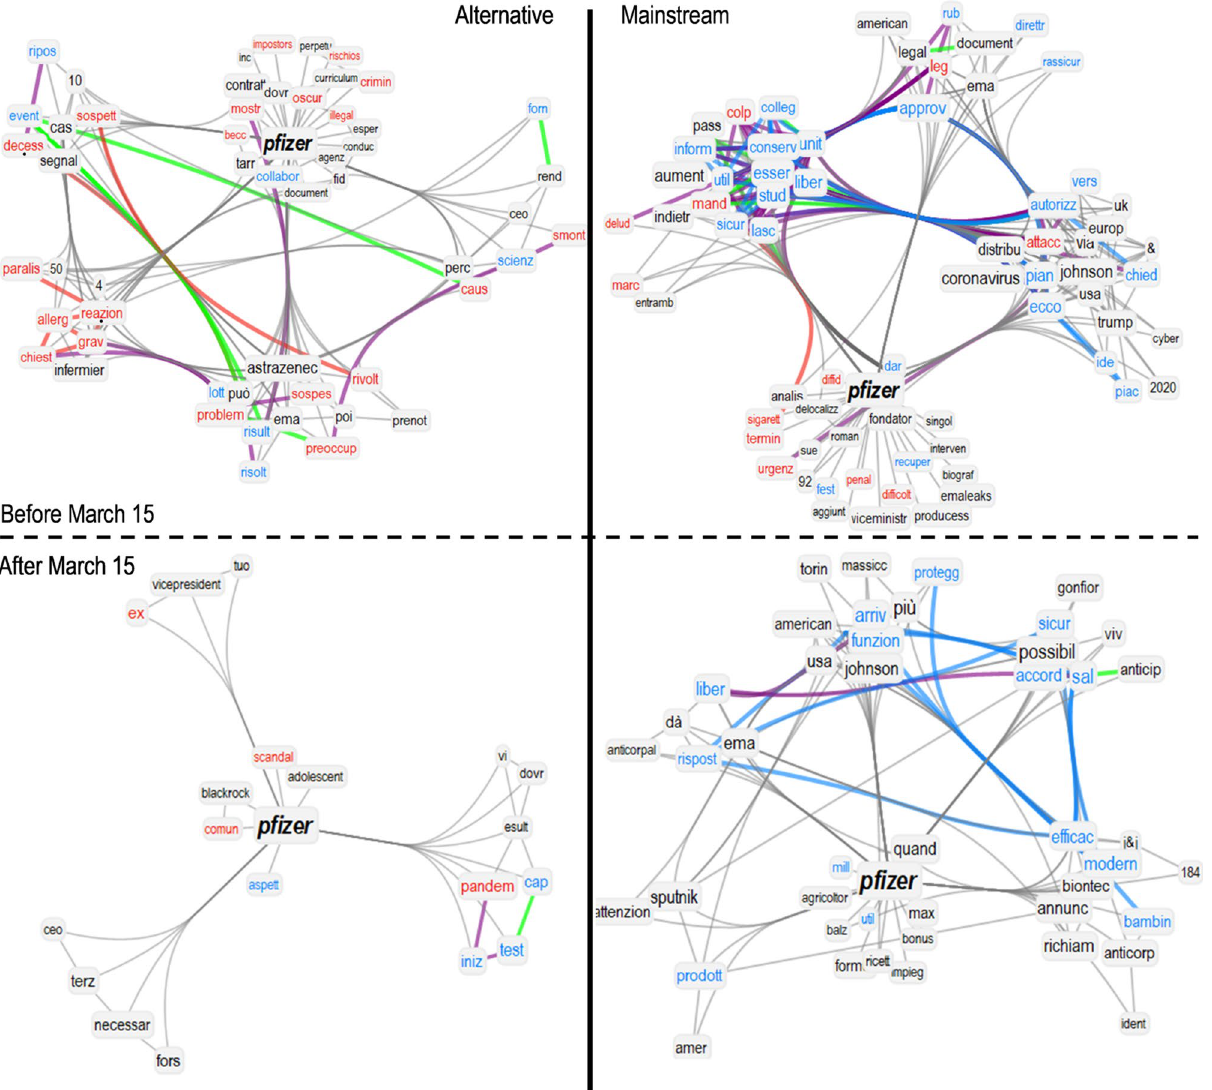
Figure 3. Semantic frames of tightly linked concepts around “pfizer” in journal news titles from mainstream sources (right) and alternative sources (left), before (top) and after (bottom) the temporary suspension of 15 March 2021. We highlighted with a dot those words discussed in detail in the main text, i.e. thrombosis, reactions, death and allergies. Syntactic links between positive (negative, neutral) words are in cyan (red, grey). Syntactic links between positive and negative words are in purple. Green links indicate